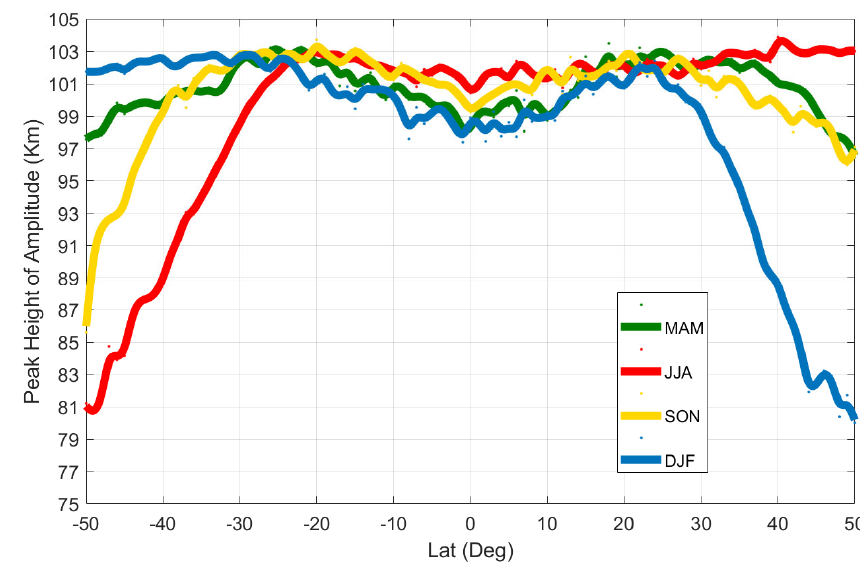
Figure 6. Latitudinal and seasonal variations in the peak height of amplitude for gravity waves in 2004. Different from the seasonal variation in the “wave turbopause” layer and PHA for 6.5